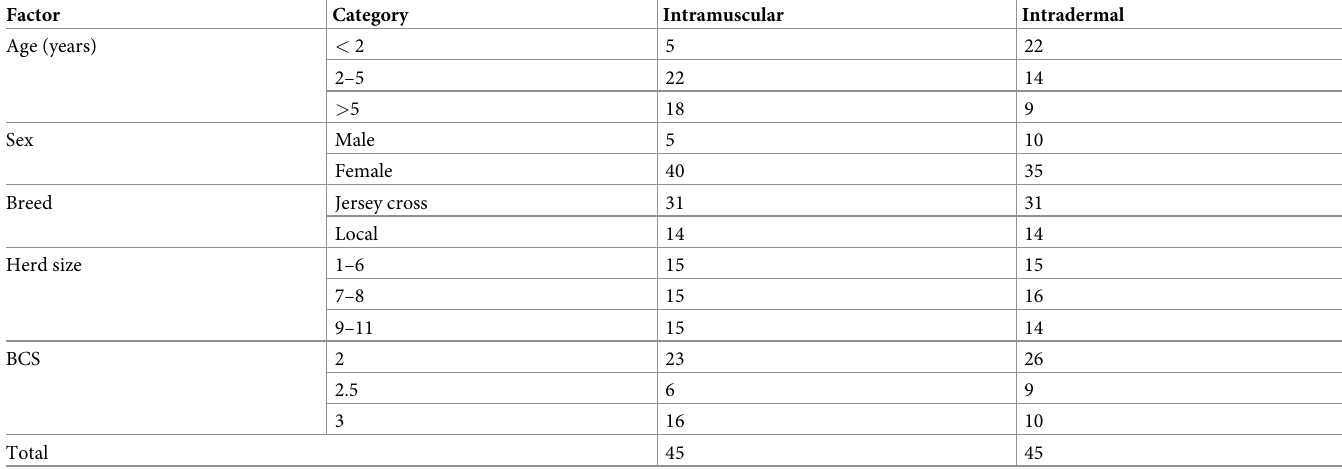
Table 1. Characteristics of cattle in each treatment group.